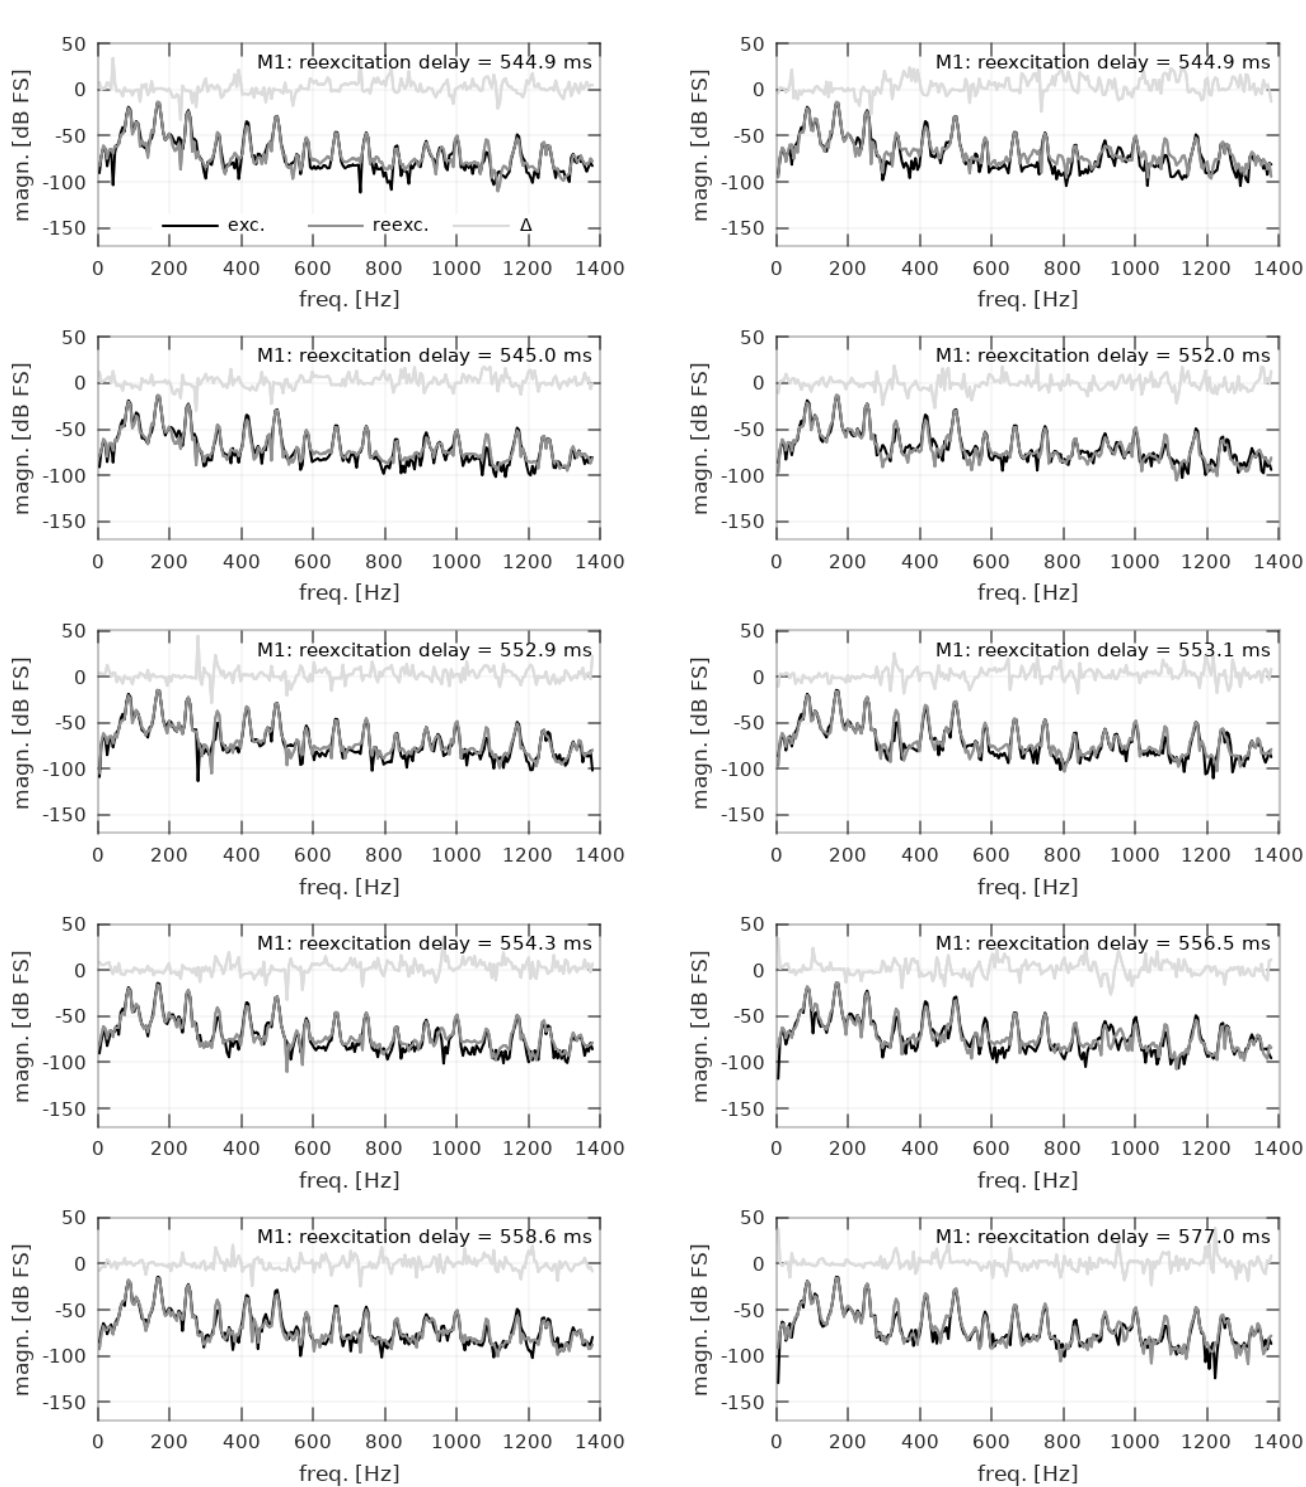
Figure 7. Robot measurements M1—spectra of primary excitation (dark plot) and re-excitation (medium) for all measured delays; ∆ (light) represents spectral